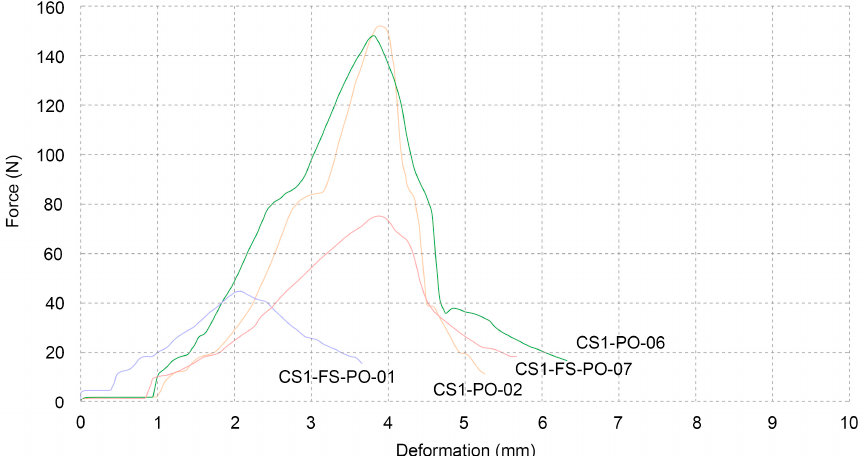
11 of 15 Figure 9. Three-point flexural test of various samples. Samples CS1-PO-06 and CS1-PO-07 consisted entirely of bleached cellulose pulp and exhibited excellent mechanical properties when compared to the other tested samples. Another technique was explored by varying the ratios of the two basic components, cel- lulose pulp and beech sawdust. The first, CS1-FS-PO-01, was made up of 30% cellulose and 70% sawdust, while the second, CS1-FS-PO-02, was made up of 70% cellulose and 30% sawdust. These were used to investigate if adding another organic component im- proved or degraded the qualities that were being measured. Even though the sample with more cellulose pulp performed better, the 30% sawdust in the sample reduced its total performance when compared to the samples that solely contained cellulose. Adding 30% cellulose to the sample consisting mainly of sawdust did not drastically change the result when compared to the average of the sawdust samples (Table 6, Figure 10). Table 6. Three-point flexural test of bleached cellulose pulp compared to blend of bleached cellulose pulp with beech sawdust. Name